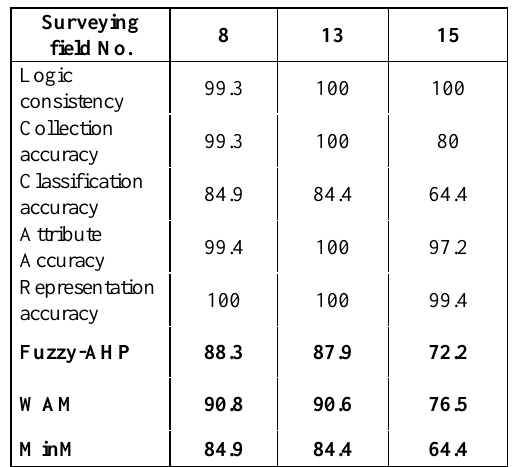
Table 4 When the scores of “Classification accuracy” are the lowest, the comparison of the final scores between the three